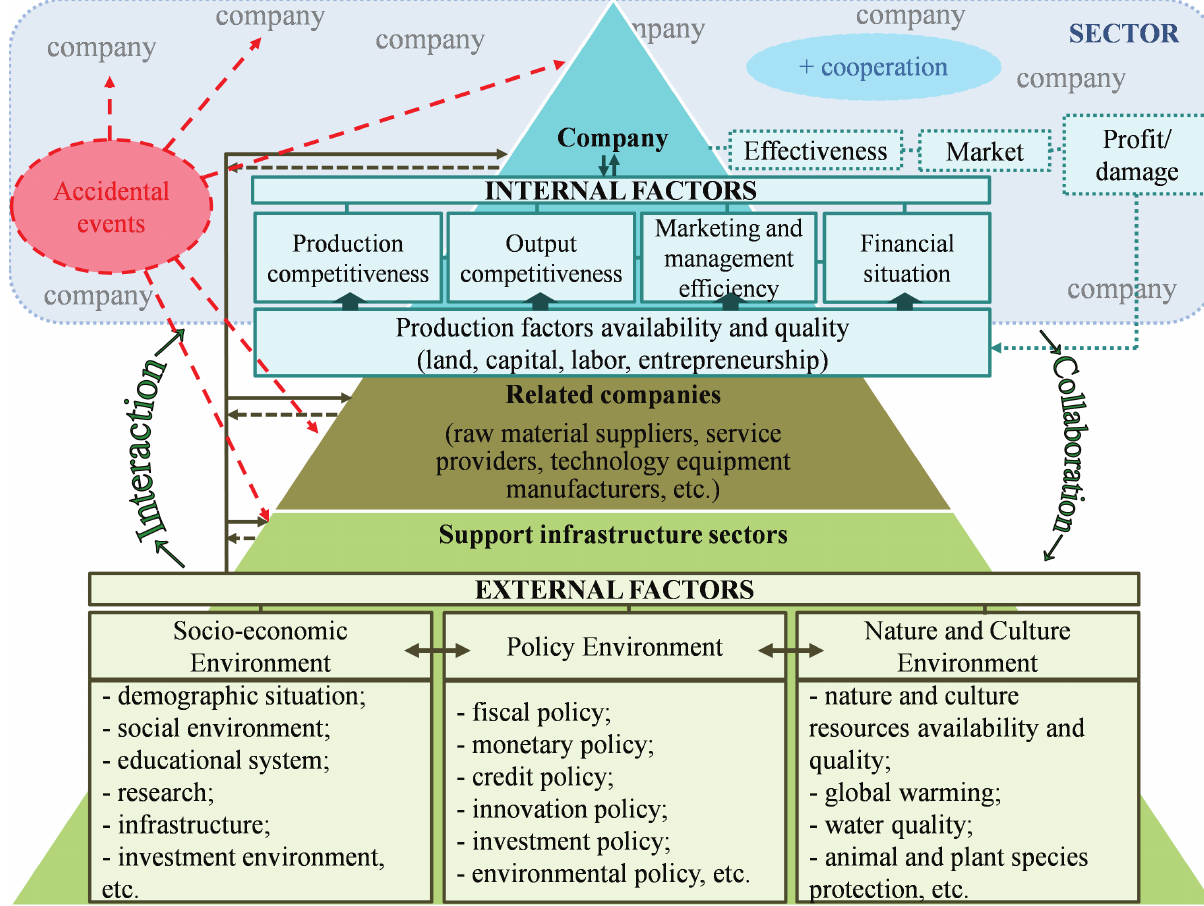
Fig. 1. Model of the factors influencing competitiveness of the Latvian fisheries sector cluster (created by the